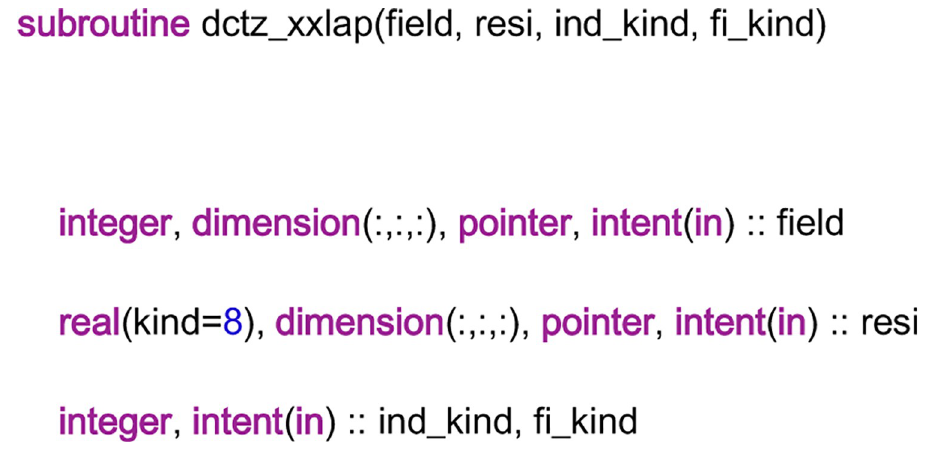
Fig 14. The head part of the code of the subroutine “dctz_xxlap”. Fig 14. From the figure, it can be seen that there are four input variables in the parameter list.